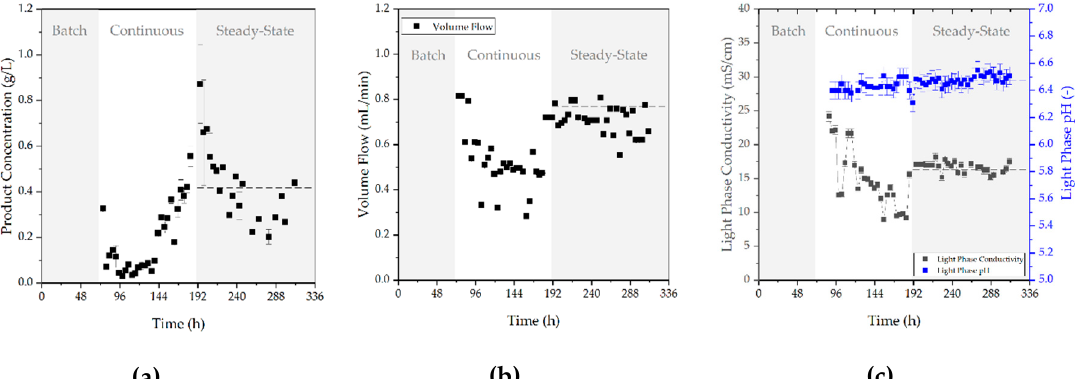
Figure 11. Product concentration ( a ), volume flow ( b ) of the light phase, and conductivity and pH-value ( c ) during batch, continuous, and continuous steady-state operation. The horizontal dashed line visualizes schematically the subsequent course of the steady-state phase after its initiation at 187 h. Error bars depict the double determination of each variable.